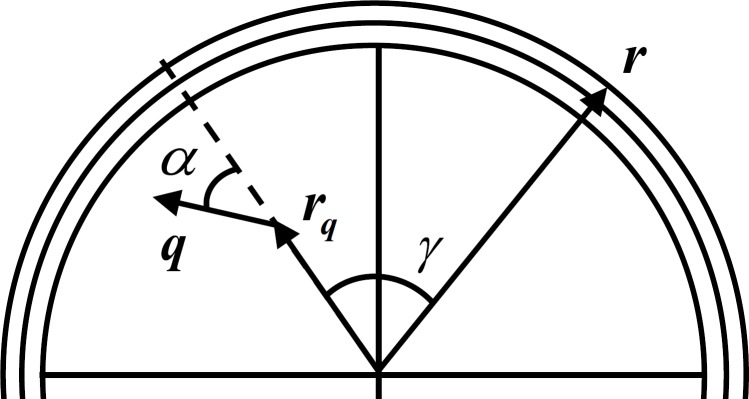
Three layer spherical head model.For one current dipole with radius rq and moment q and scalp electrode with radius r oriented with angles α and γ, respectively. Adapted from Mosher, Leahy & Lewis (1999).